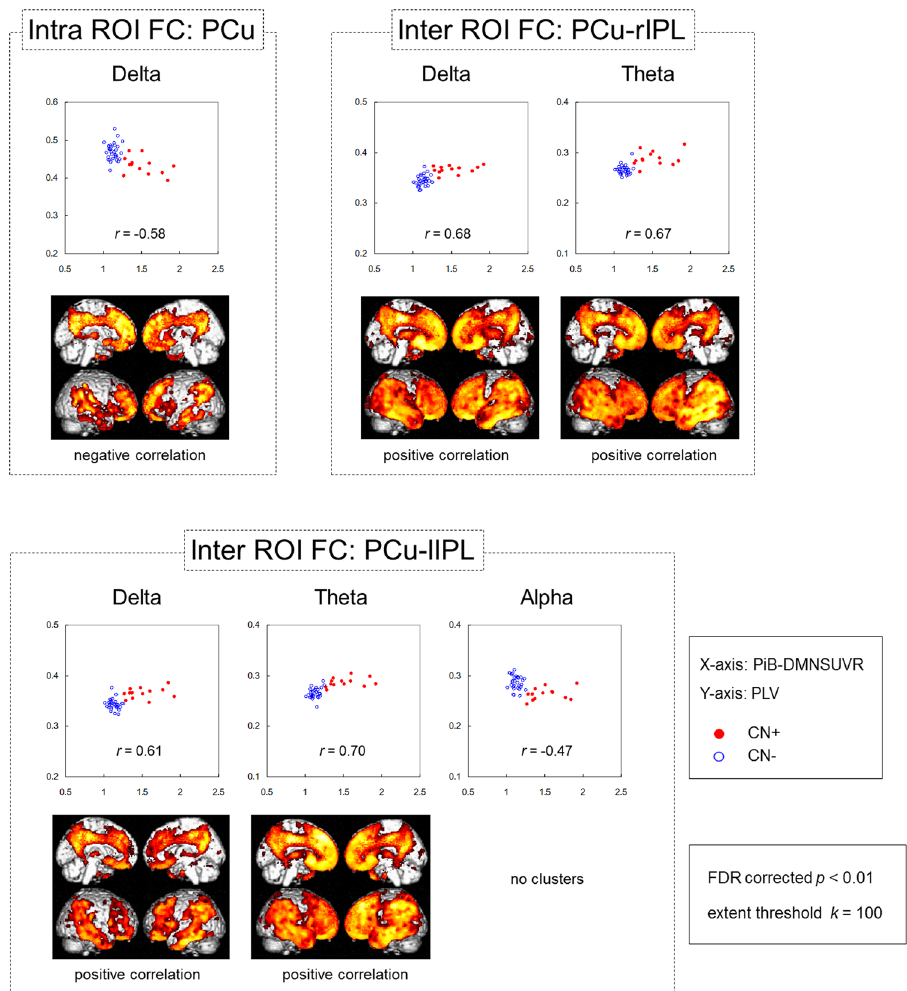
Figure 3. Correlations between each MEG FC marker and cerebral amyloid deposition. The scatter plots show correlation between the PiB-DMNSUVR values (x axis) and PLV (y axis). The closed red circles and open blue circles indicate CN + and CN − individuals, respectively. The brain images display the results of regression analysis between PiB-SUVR images and each MEG FC marker’s PLV. Brain areas that showed statistically significant correlations between regional PiB retention and each biomarker are visualized. The height threshold is p < 0.01 (FDR corrected), and the extent threshold is k = 200 voxels in all images. Note that the regression analyses for PCu-lIPL alpha showed no significant clusters with the above thresholds. FC: functional connectivity, DMNSUVR: mean standardized uptake value ratio (SUVR) within the default mode network (DMN). PLV: phase-locking value, CN + : cognitively normal PiB-positive, CN − : cognitively normal PiB-negative, FDR: false discovery rate, PCu: precuneus, lIPL; left inferior parietal